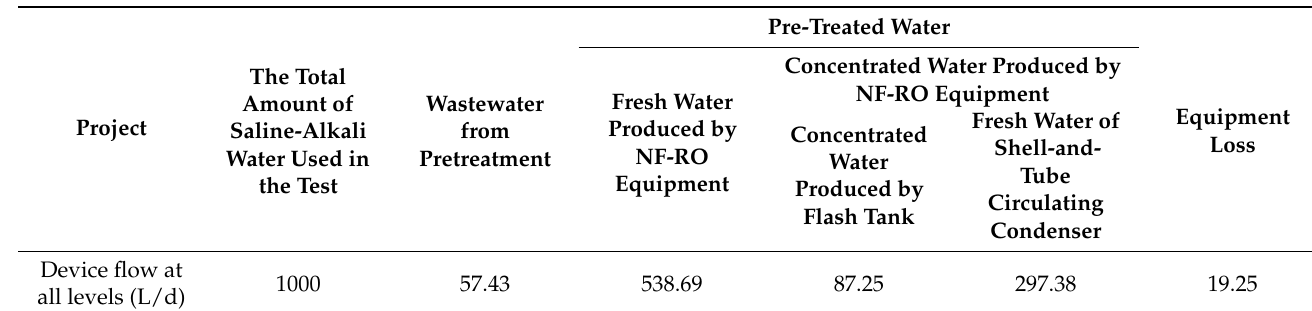
Table 5. Water production at all levels of